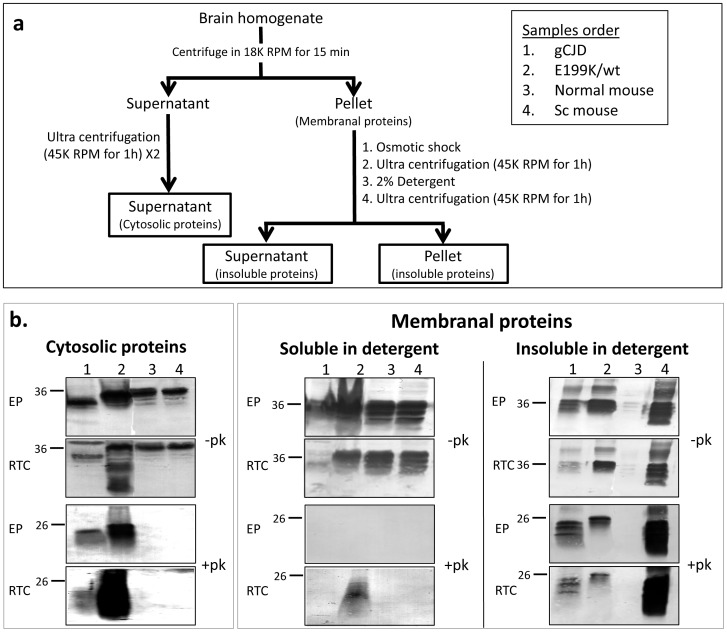
PrP forms in soluble and membranal brain fractions.(a) Fractionation protocol of brain homogenates. (b) Soluble and membranal brain fractions were digested in the presence and absence of PK and immunoblotted with two α-PrP c-terminal Ab; pAb RTC and mAb EP1802Y (EP) (see figure 2a for epitope mapping).